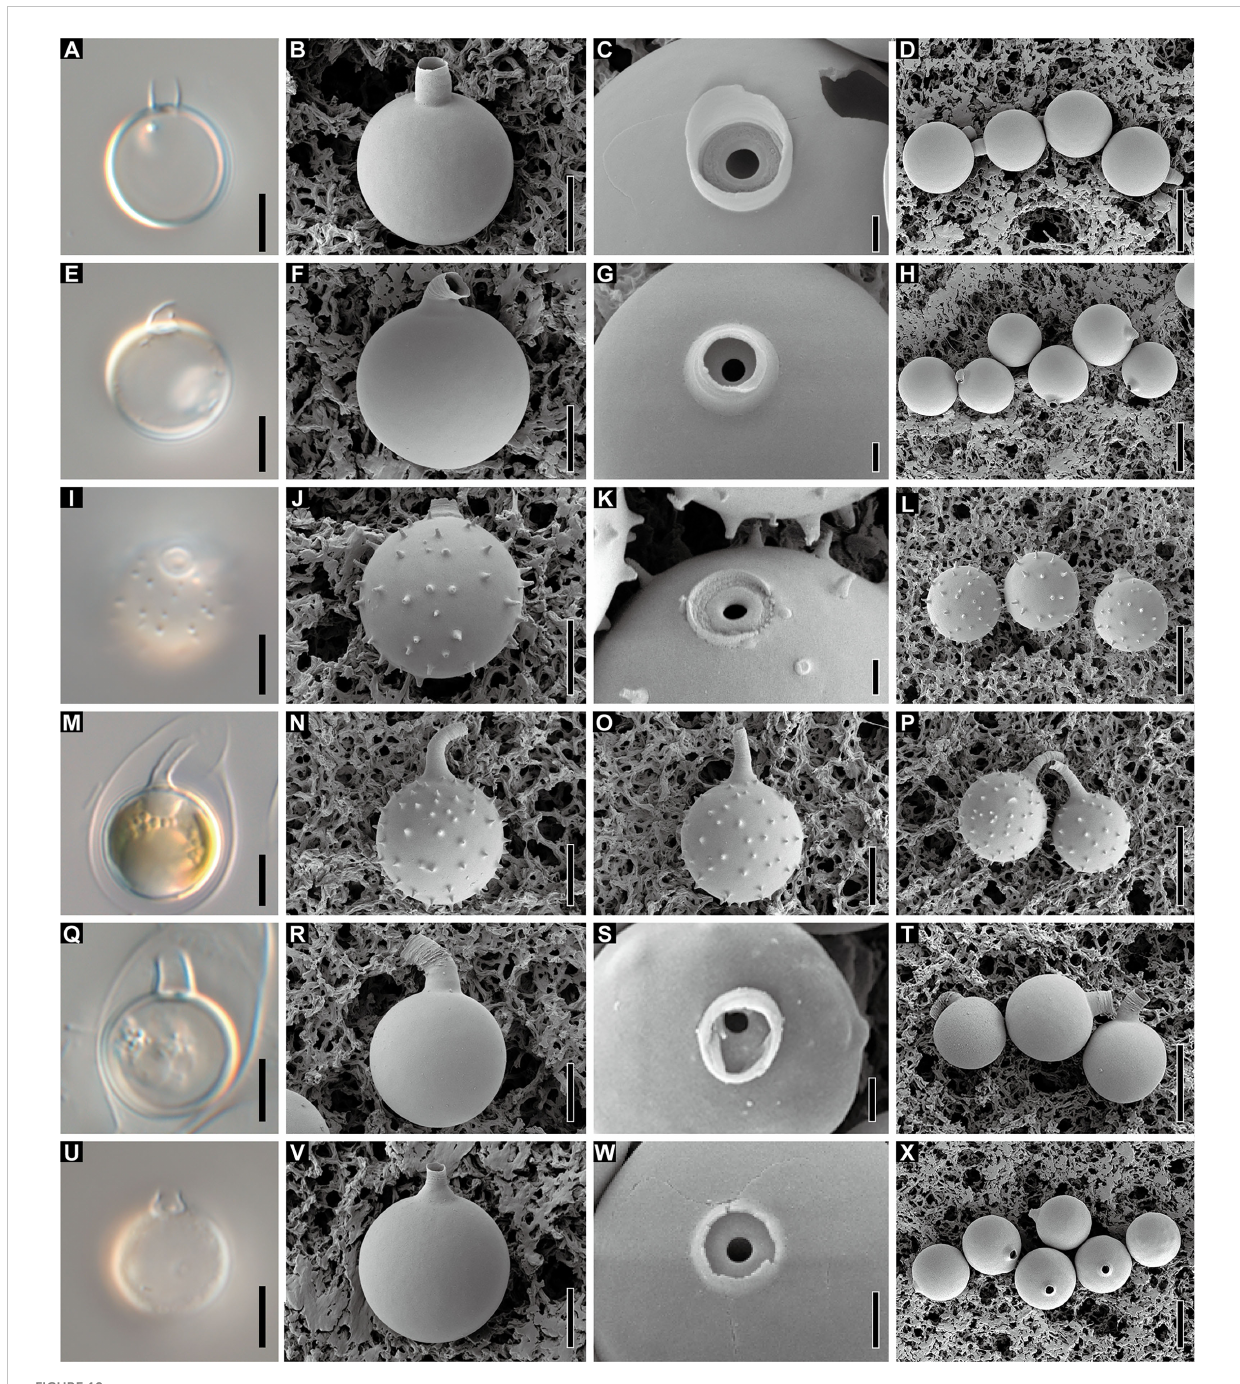
FIGURE 10 Light and scanning electron micrographs of stomatocyst. (A – D) Images of the spherical stomatocyst of D. cylindricollarium Myeoseul111618D. (E – H) Images of the oblate stomatocyst of D. inclinatum Chojeon011219A. (I – L) Images of the spherical stomatocyst of D. spinum Geumgok020610D. (M – P) Images of the spherical stomatocyst of D. taiyuanensis Yookho031321MS4. (Q – T) Images of the spherical stomatocyst of D. cylindricum var. palustre Bonghwa040718C. Scale bars of A, B, E, F, I, J, M, N, Q, R = 5 µm; C, G, K, O, S = 1 µm; D, H, L, P, T = 10